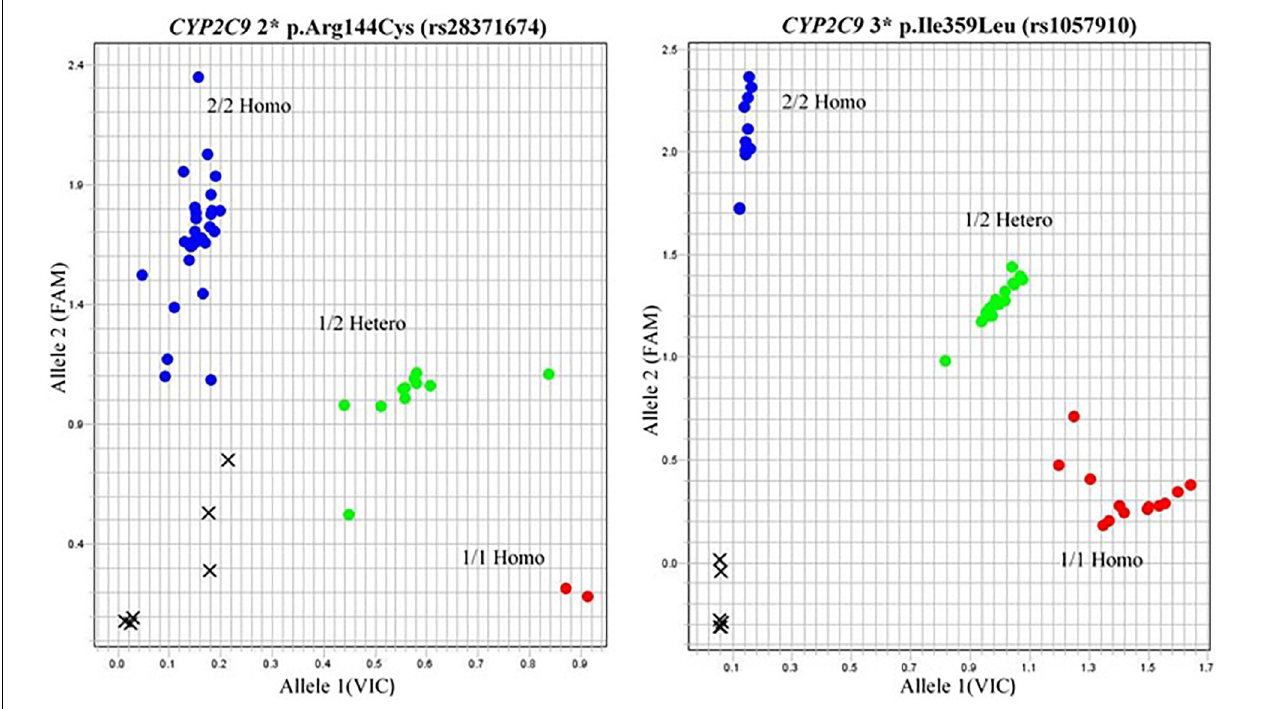
FIGURE 4 | Allelogram showing CYP2C9 2* and 3* SNP genotyping in the blue dotted area. TABLE 2 | Comparison of fold change expression of target genes in low and high warfarin dose groups calculated by (cid:49)(cid:49) CT method in Pakistani subjects. Warfarin dose gps Expression